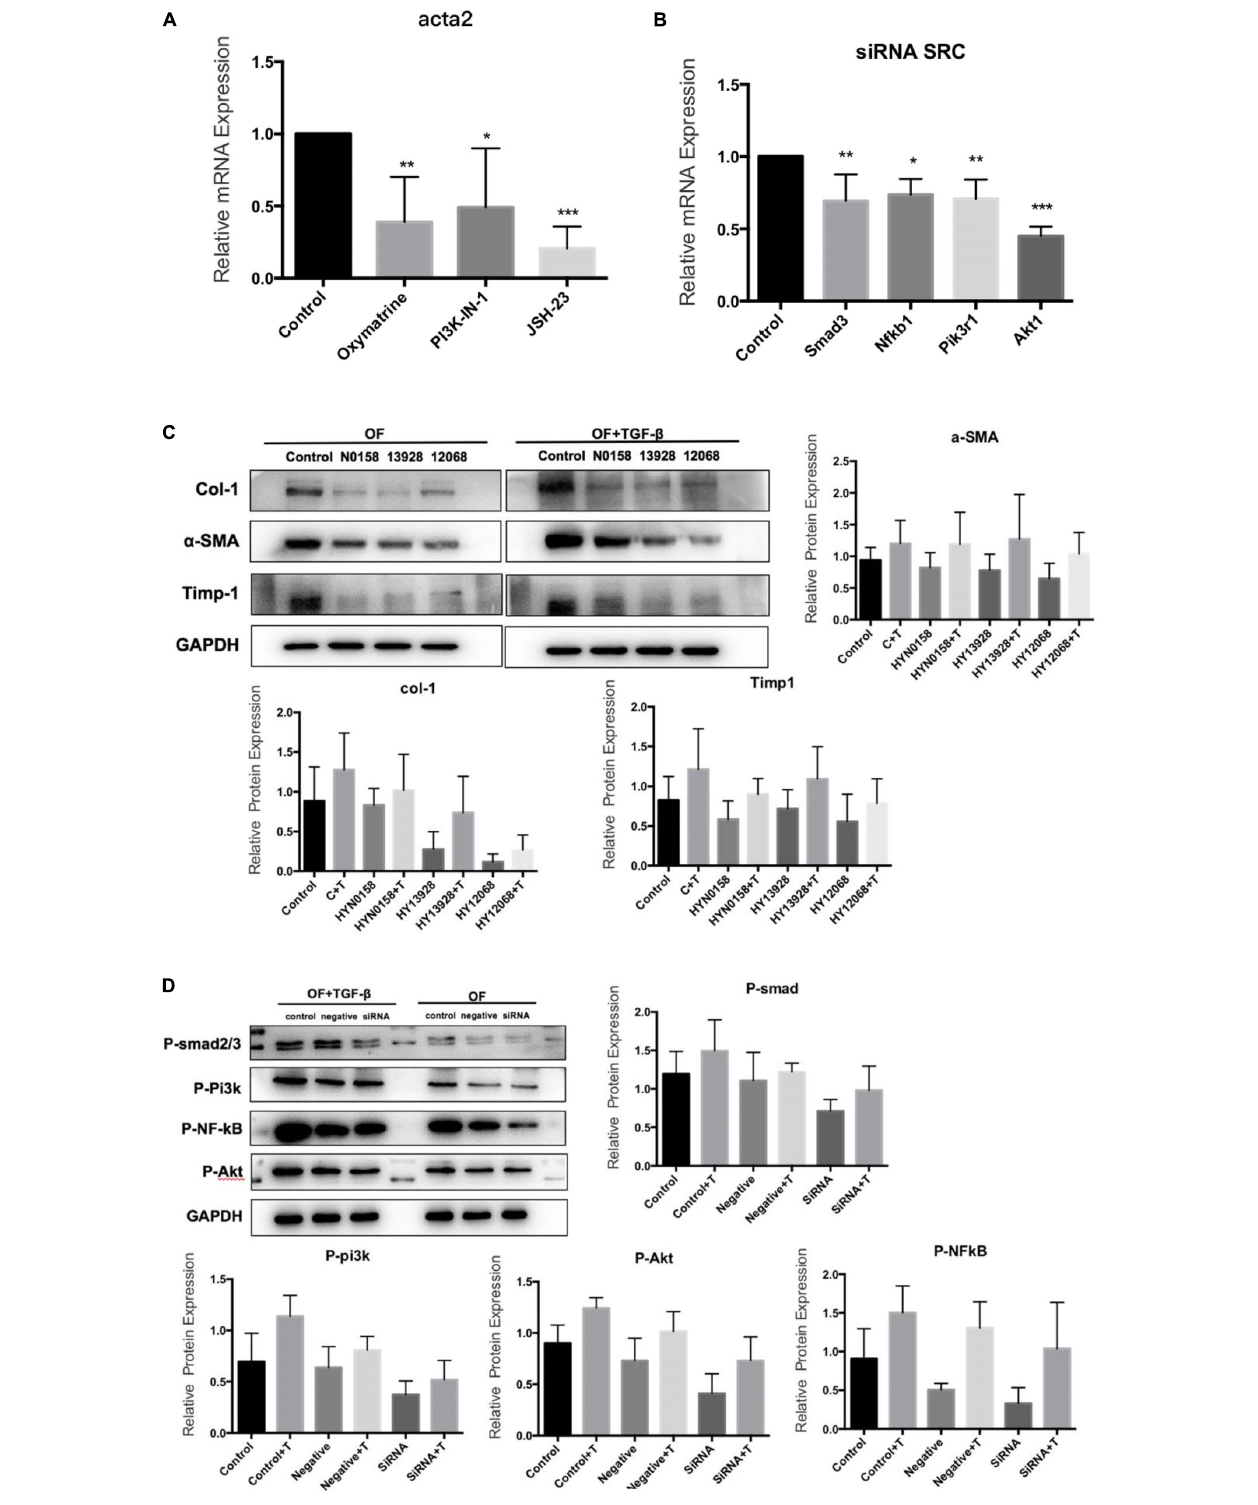
FIGURE 8 | Signaling inhibitors. (A) Acta2 expression after Signaling inhibitors by q-PCR; (B) the expression of Smad3, Nfkb1, Pik3r1, and Akt1 in the SRC gene knockdown group by q-PCR; (C) the expression of α -SMA, Col-1, and Timp-1 after Signaling inhibitors by western blot; (D) the phosphorylation of SMAD2/3, NF- κ B p65 and PI3K p85 proteins in SRC gene knockdown group by western